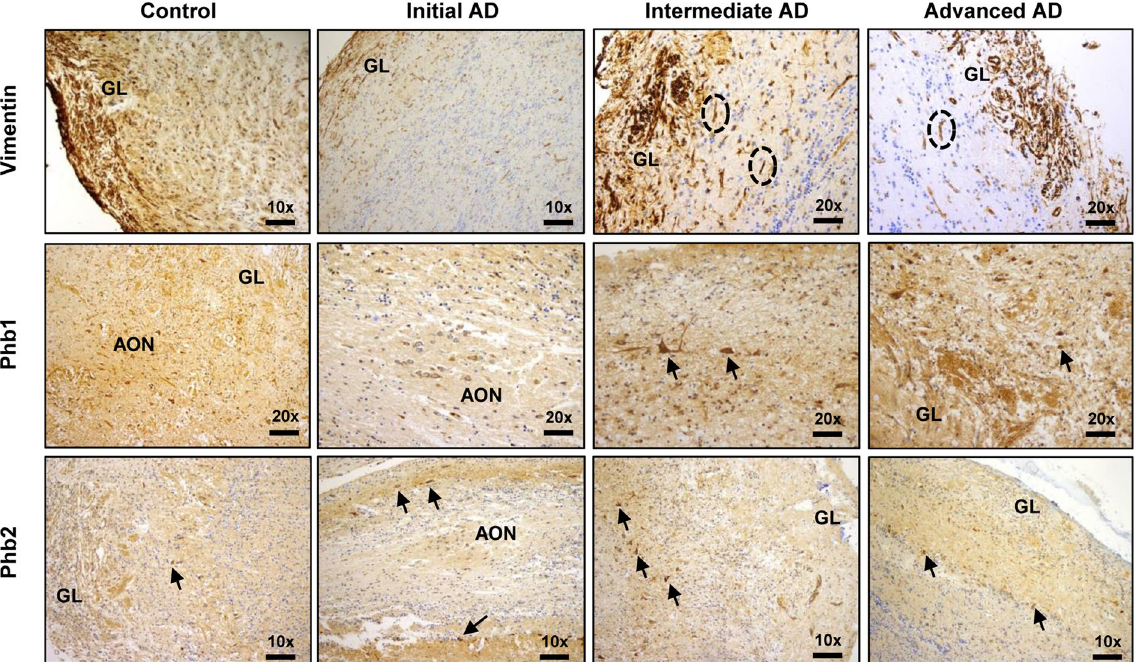
Figure 6. Immunohistochemical localization of OB Vim, Phb1 and Phb2 across AD grading. First line: Representative immunohistochemical staining pattern of Vim across AD grading. Positive staining in glomerular cell layer (GL) and wall of endothelial cells (ovals). Second line: Representative immunohistochemical staining pattern of Phb1 across AD grading. Positive staining in glomerular layer (GL), anterior olfactory nucleus (AON), and mitral cells (asterisks). Third line: Representative immunohistochemical staining pattern of Phb2 across AD grading. Positive staining in glomerular layer (GL), anterior olfactory nucleus (AON), and mitral cells